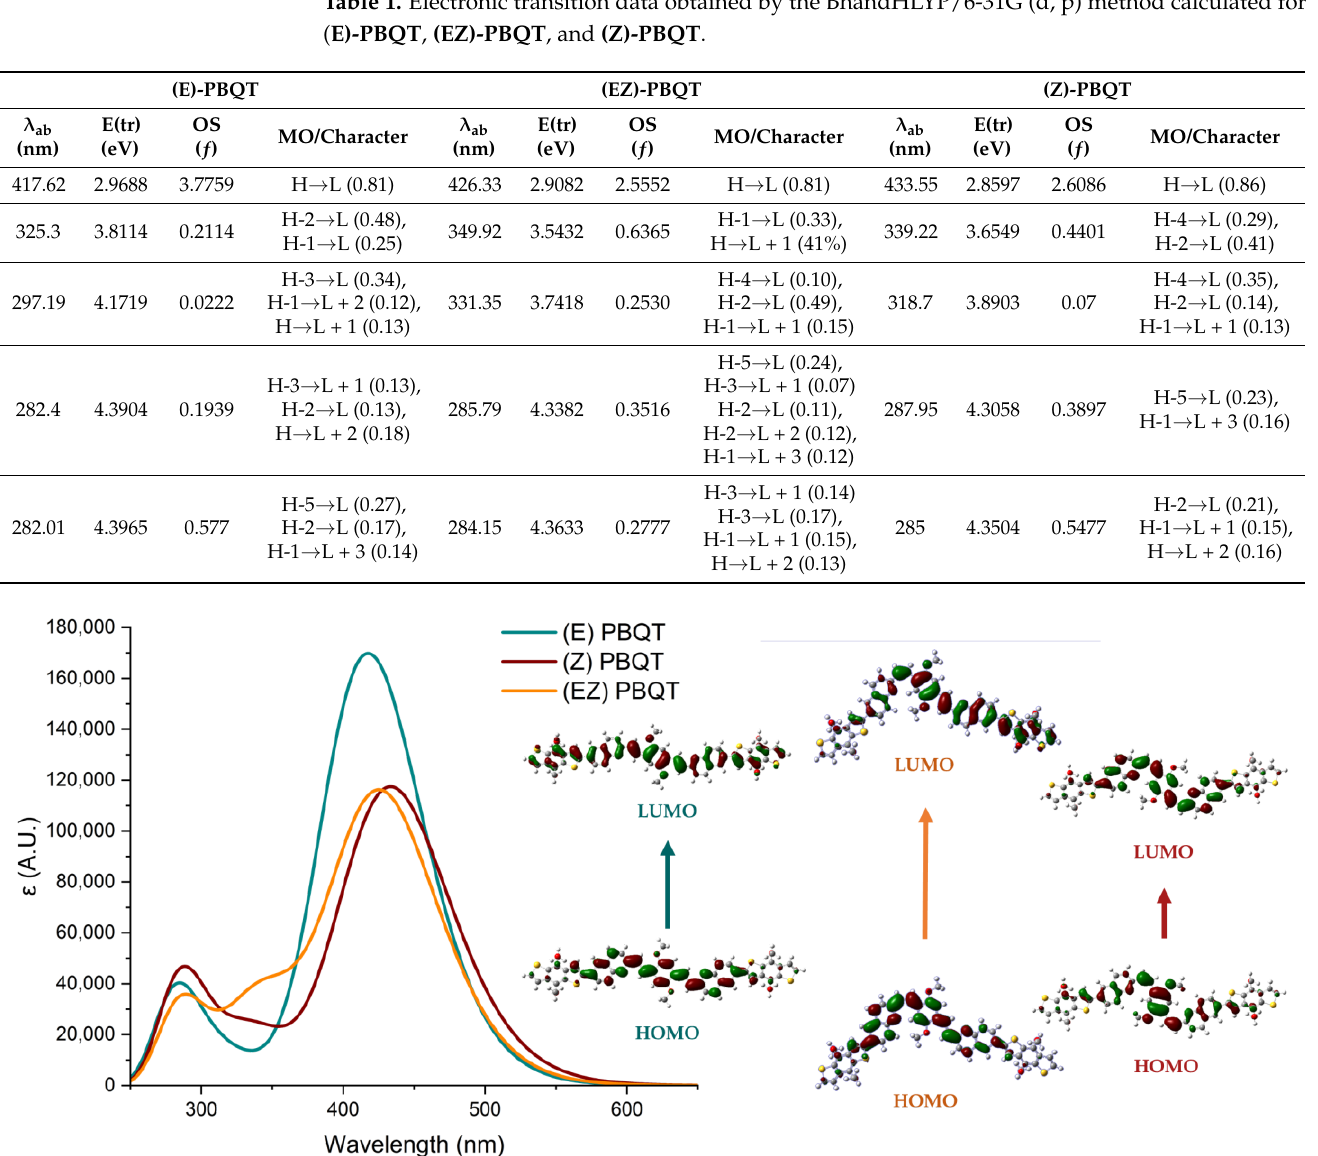
Table 1. Electronic transition data obtained by the BhandHLYP/6-31G (d, p) method calculated for